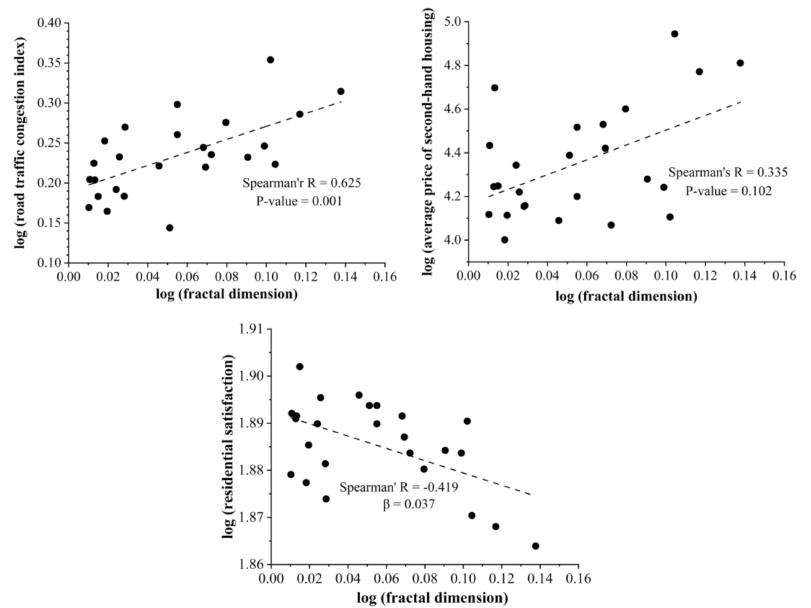
Figure 5. Fitting results between fractal dimensions of metro networks and socioeconomic